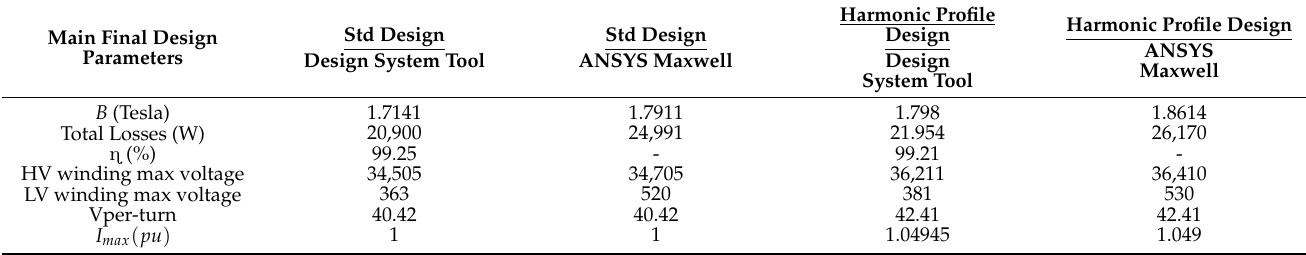
Table 6. Summary of design parameter